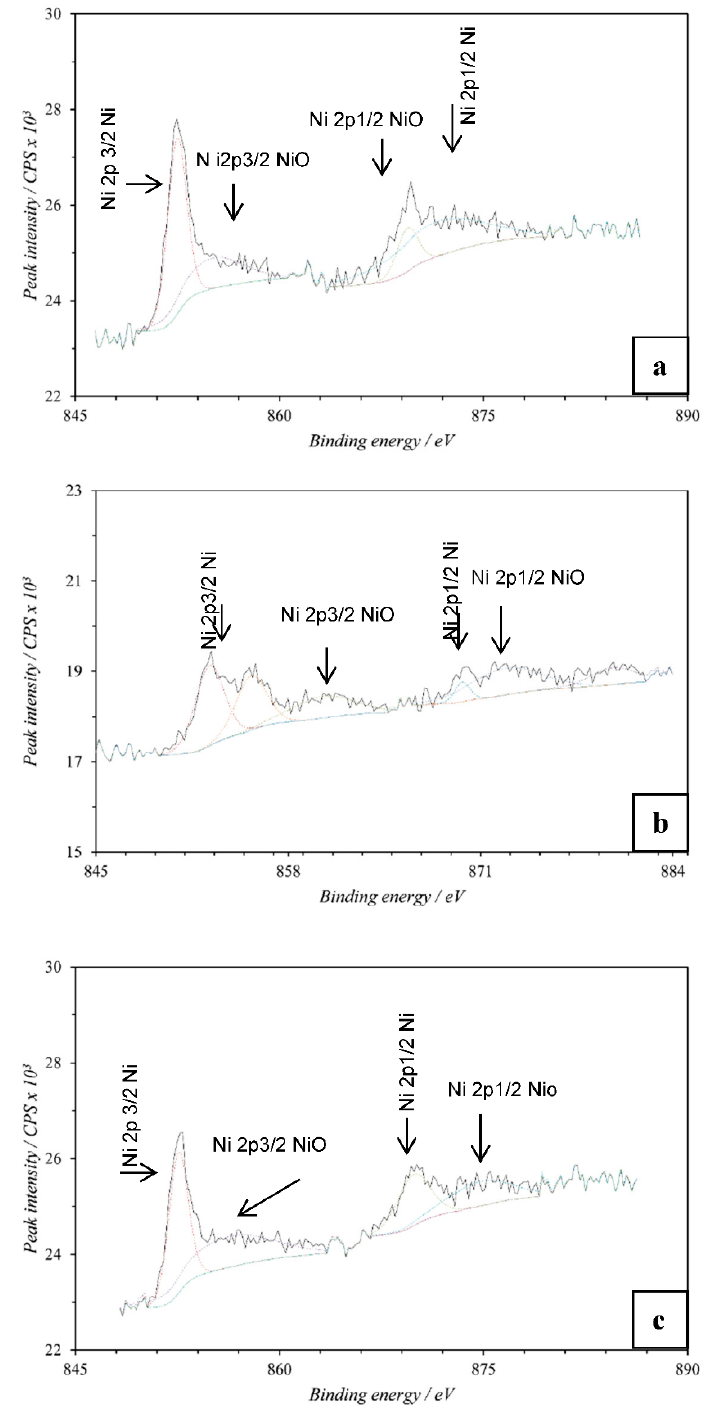
Figure 13. High resolution spectra of Ni 2p peaks, ( a ) sample exposed for 24 h, ( b ) sample polarized to 100 mV and ( c ) sample polarized to 1000 mV before polarization.